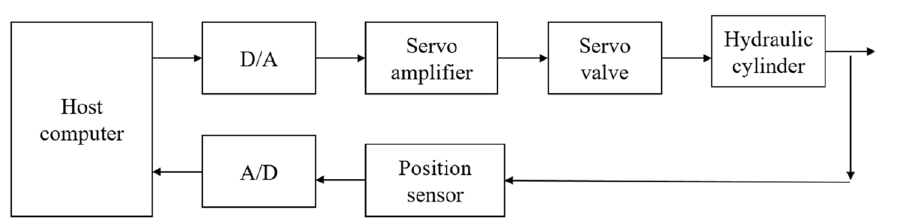
Figure 7. Schematic diagram of wave compensation control